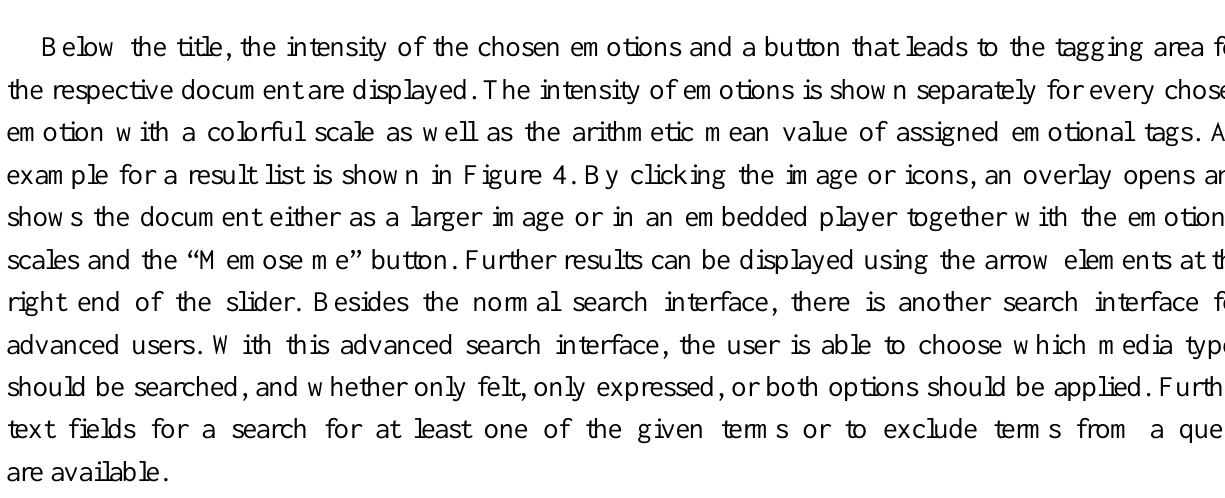
Figure 4. Search results in a tabbed slider